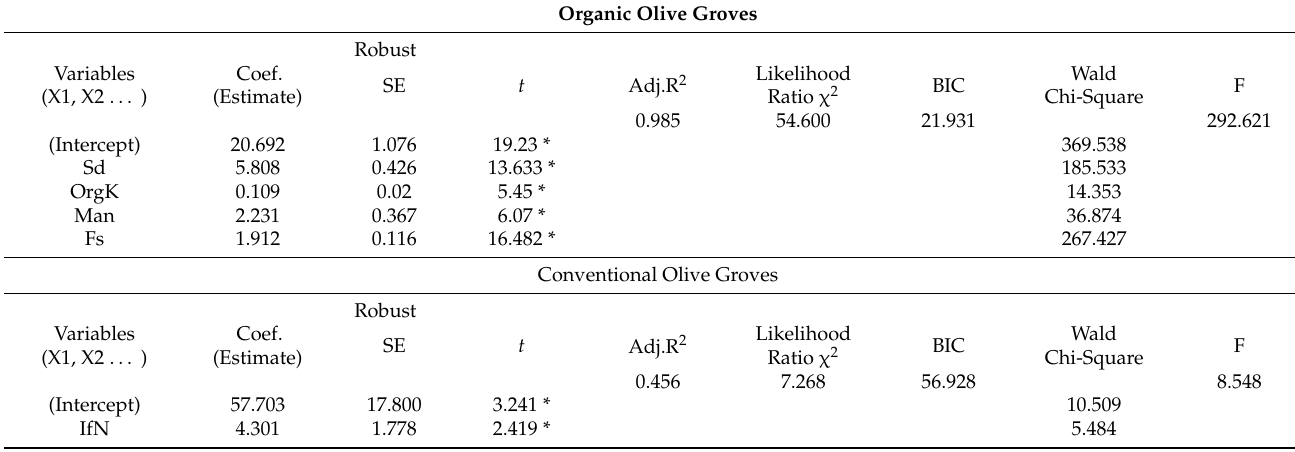
Table 5. Factors influencing herbaceous plant species richness (Y variable) in organic and conventional olive groves. Organic Olive Groves Robust